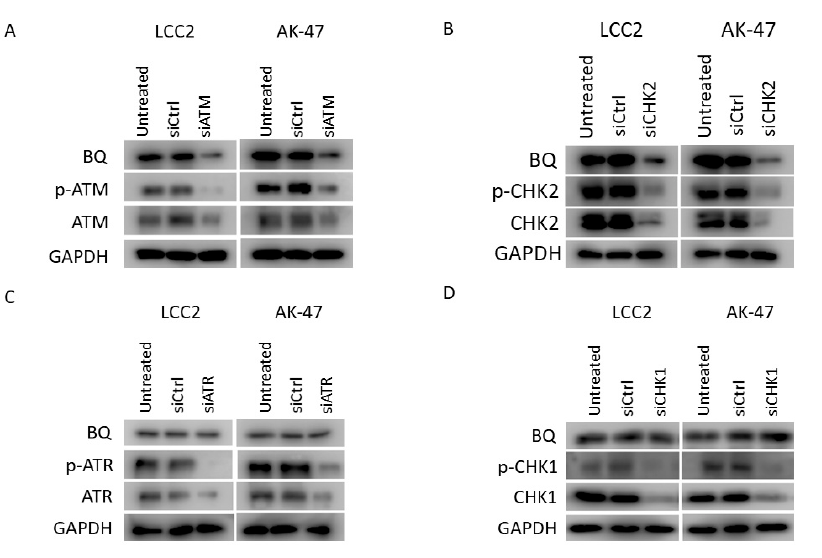
Figure 2. Knockdown of ATM and CHK2 could reduce BQ expression. ( A ) The effect of ATM knockdown on pATM (Ser1981) and BQ expression. ( B ) The effect of CHK2 knockdown on p-CHK2 (Thr68) BQ expression. ( C ) The effect of ATR knockdown on p-ATR (Ser1989) BQ expression. ( D ) The effect of CHK1 knockdown on p-CHK1 (Ser345) and BQ expression. LCC2 and AK-47 cells were transfected with 20 nM of the siRNA. Cells were harvested 72 h post-transfection. Western blot was employed to detect the expression of candidate proteins. GAPDH was used as the loading control.